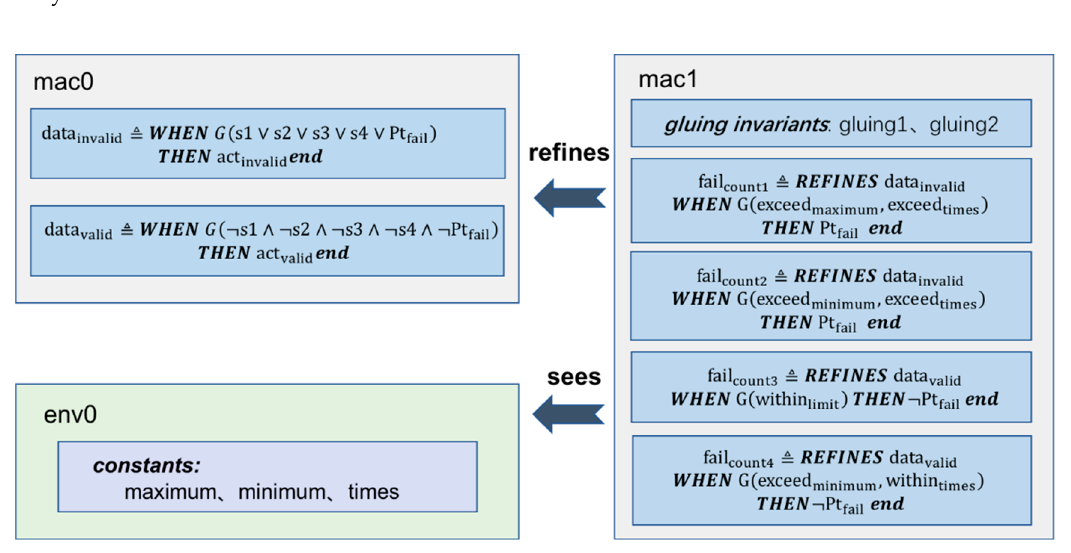
Figure 5. Event-B model.